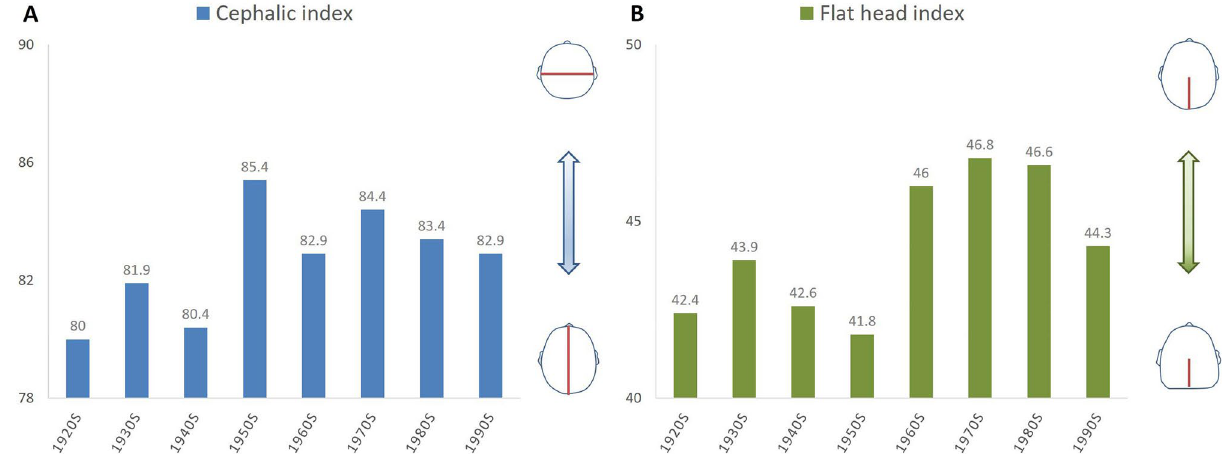
Figure 2. Average values of cephalic index ( A ) and flat head index ( B ) by birth year. People born from the 1950s onwards showed a shorter cranial length, and those born until the 1950s tend to display a stronger occipital